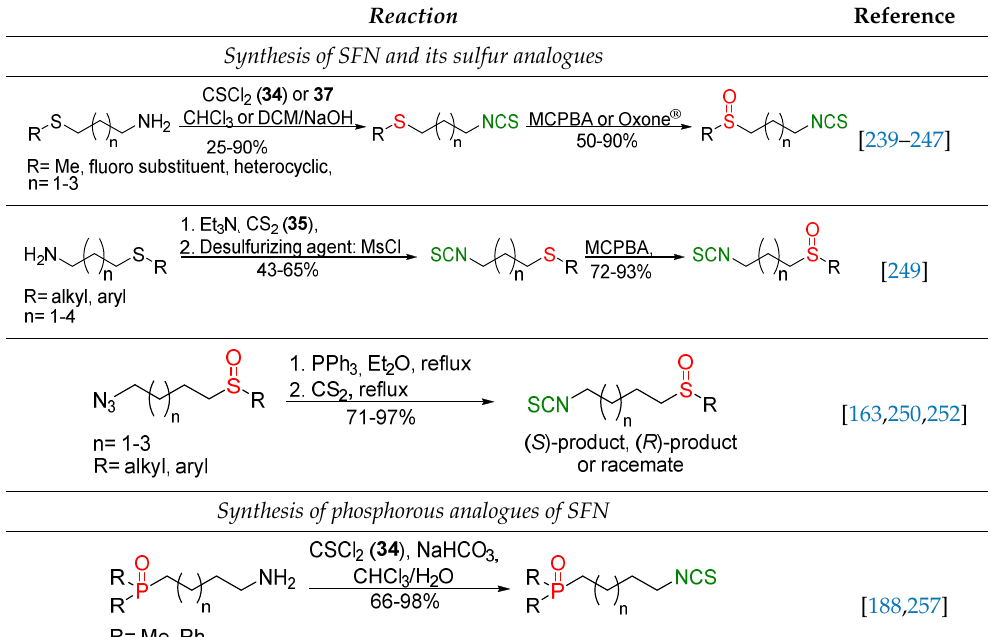
Table 12. Summary of the synthetic routes of SFN and its bifunctional analogs.